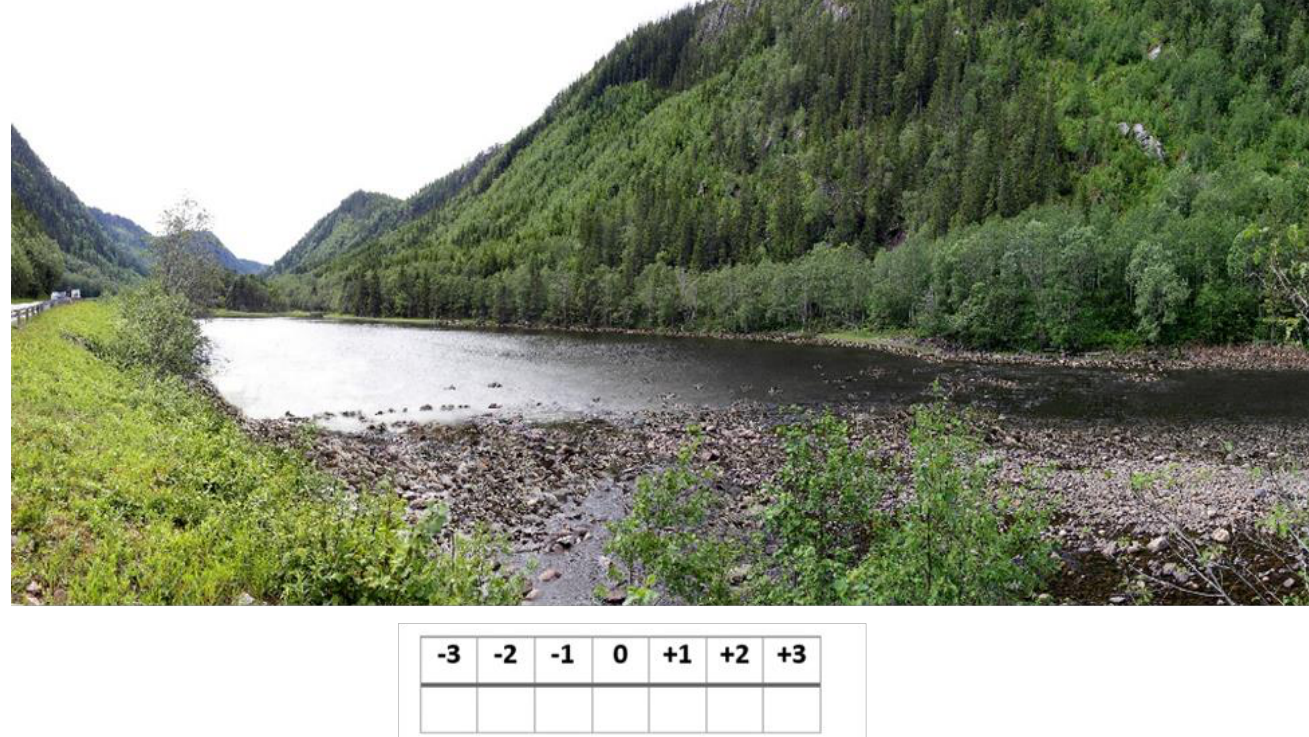
Figure 6. Visual scenario example from the questionnaire with the complementary answer scale. The scenario represents the on-the-ground-perspective with the weir removed at weir no. 22 (visual scenario: Rolseth Foto).